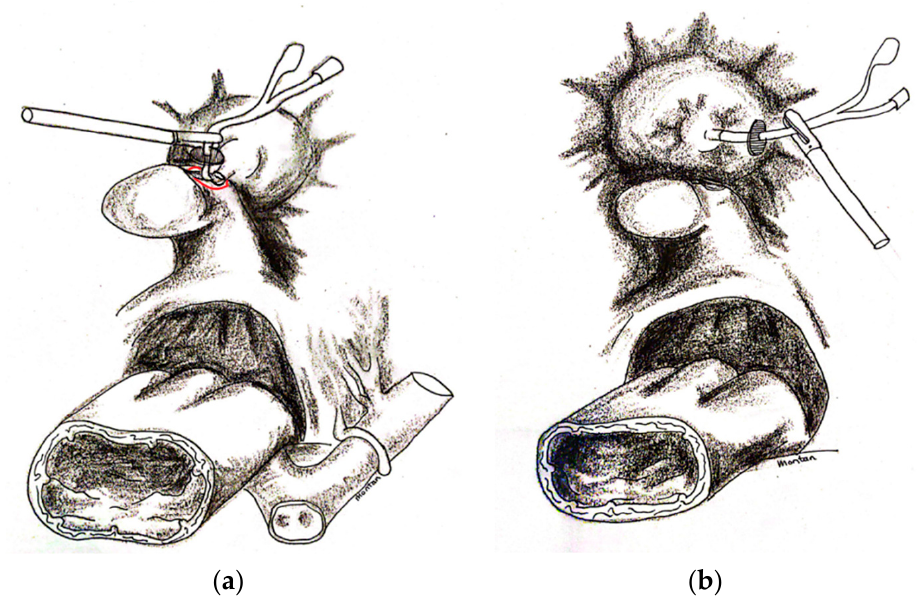
Figure 3. ( a ) The anterior vaginal wall was opened using monopolar to expose the distal end of the catheter with the channels. The latter part was pulled in the abdomen and the anterior vaginal wall was opened longitudinally to reach the VVF. The vaginal part of the VVF was fully resected around the catheter from the vaginal mucosa until the catheter was freed from the vagina . ( b ) At this point the Foley catheter was only held by the vesical part of the VVF.